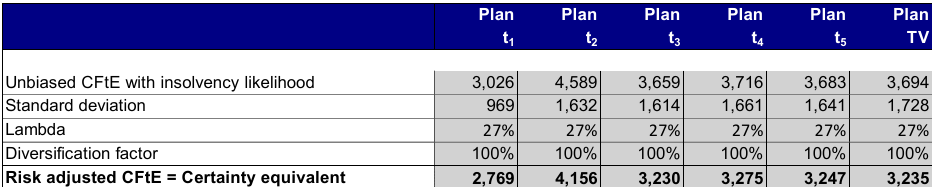
Figure 10. Calculation of the risk-adjusted cash flow to equity for the certainty equivalent method.